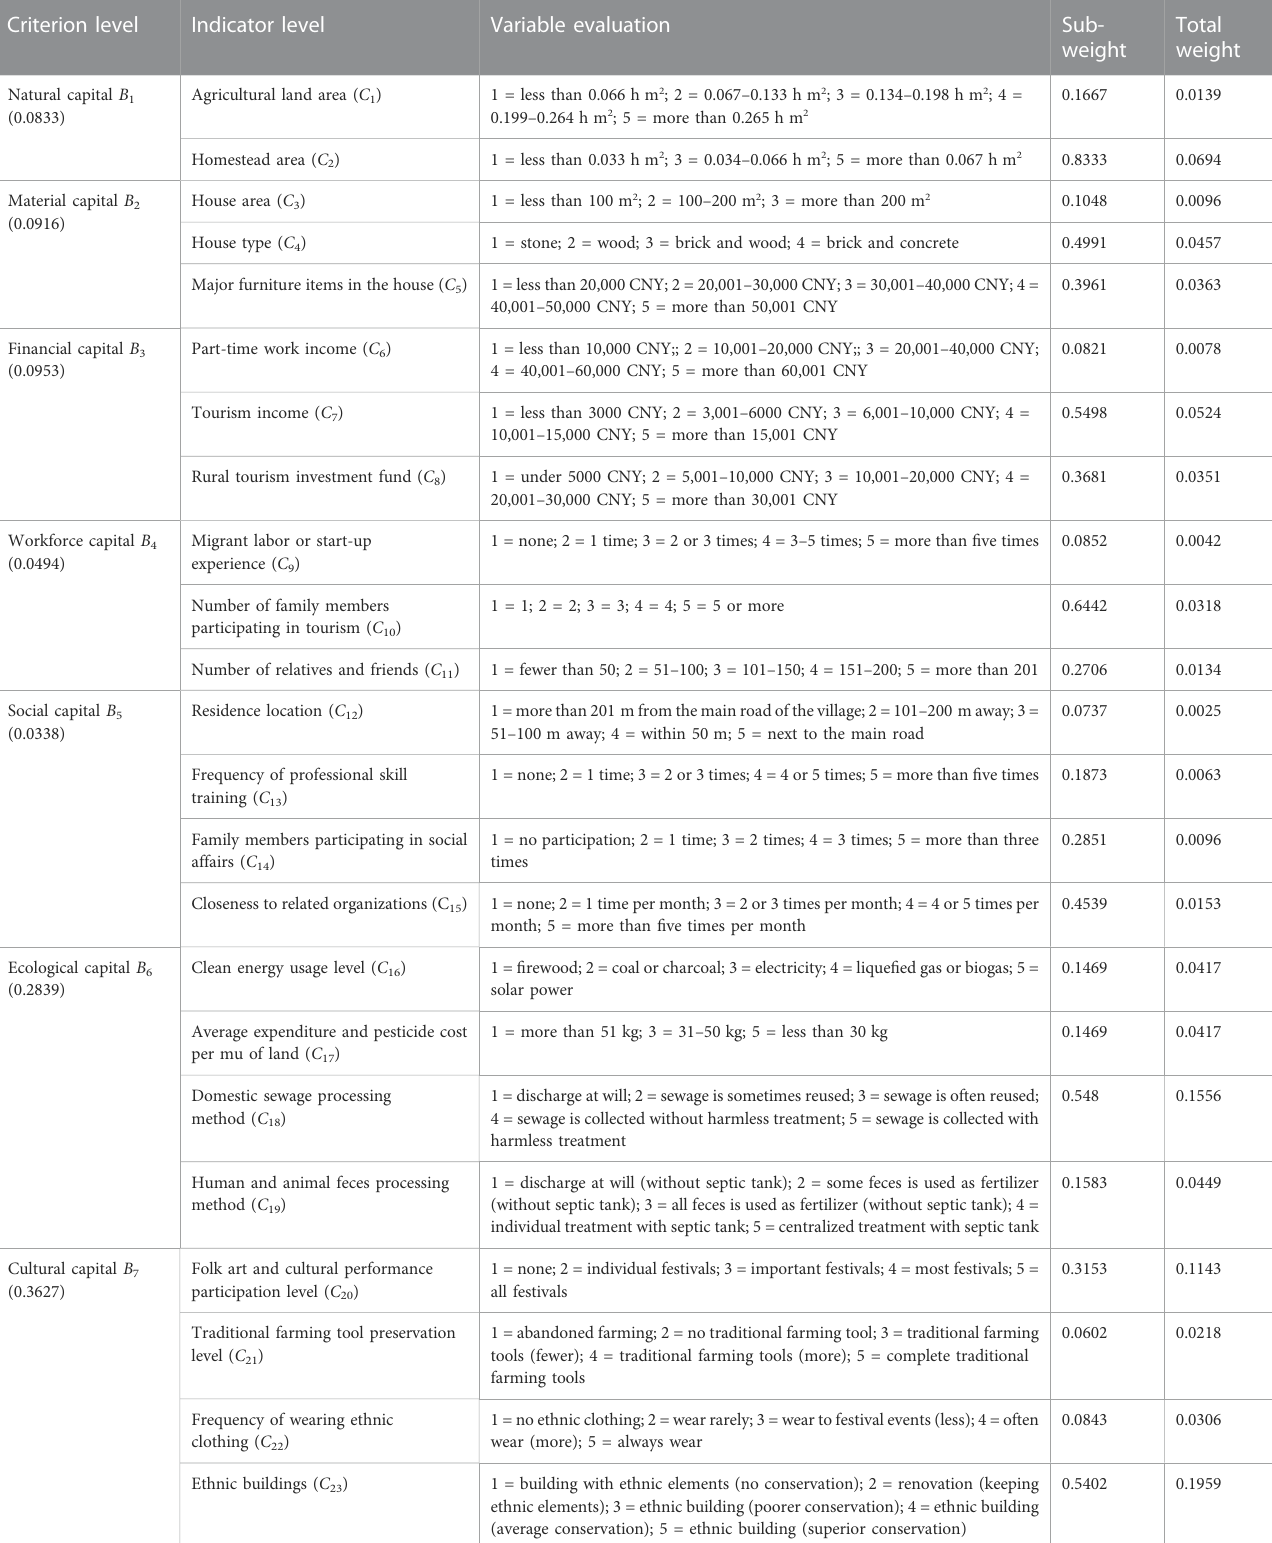
TABLE 2 Indicator system of farmers ’ sustainable livelihood responses to rural ecocultural tourism. Criterion